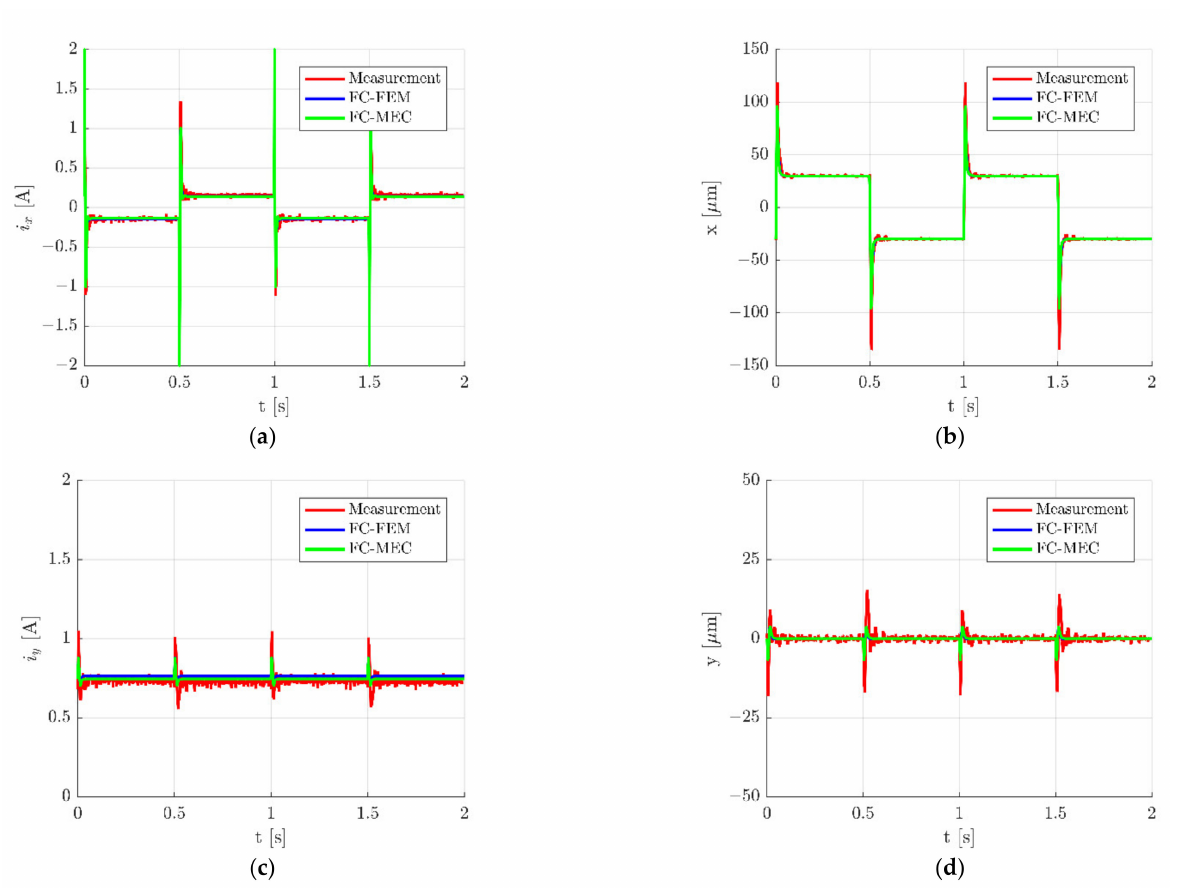
Figure 10. Time responses of the control current i x ( a ), the rotor position x ( b ), the control current i y ( c ) and the rotor position y ( d ) for the step change ± 30 µ m of the rotor position along the x -axis.